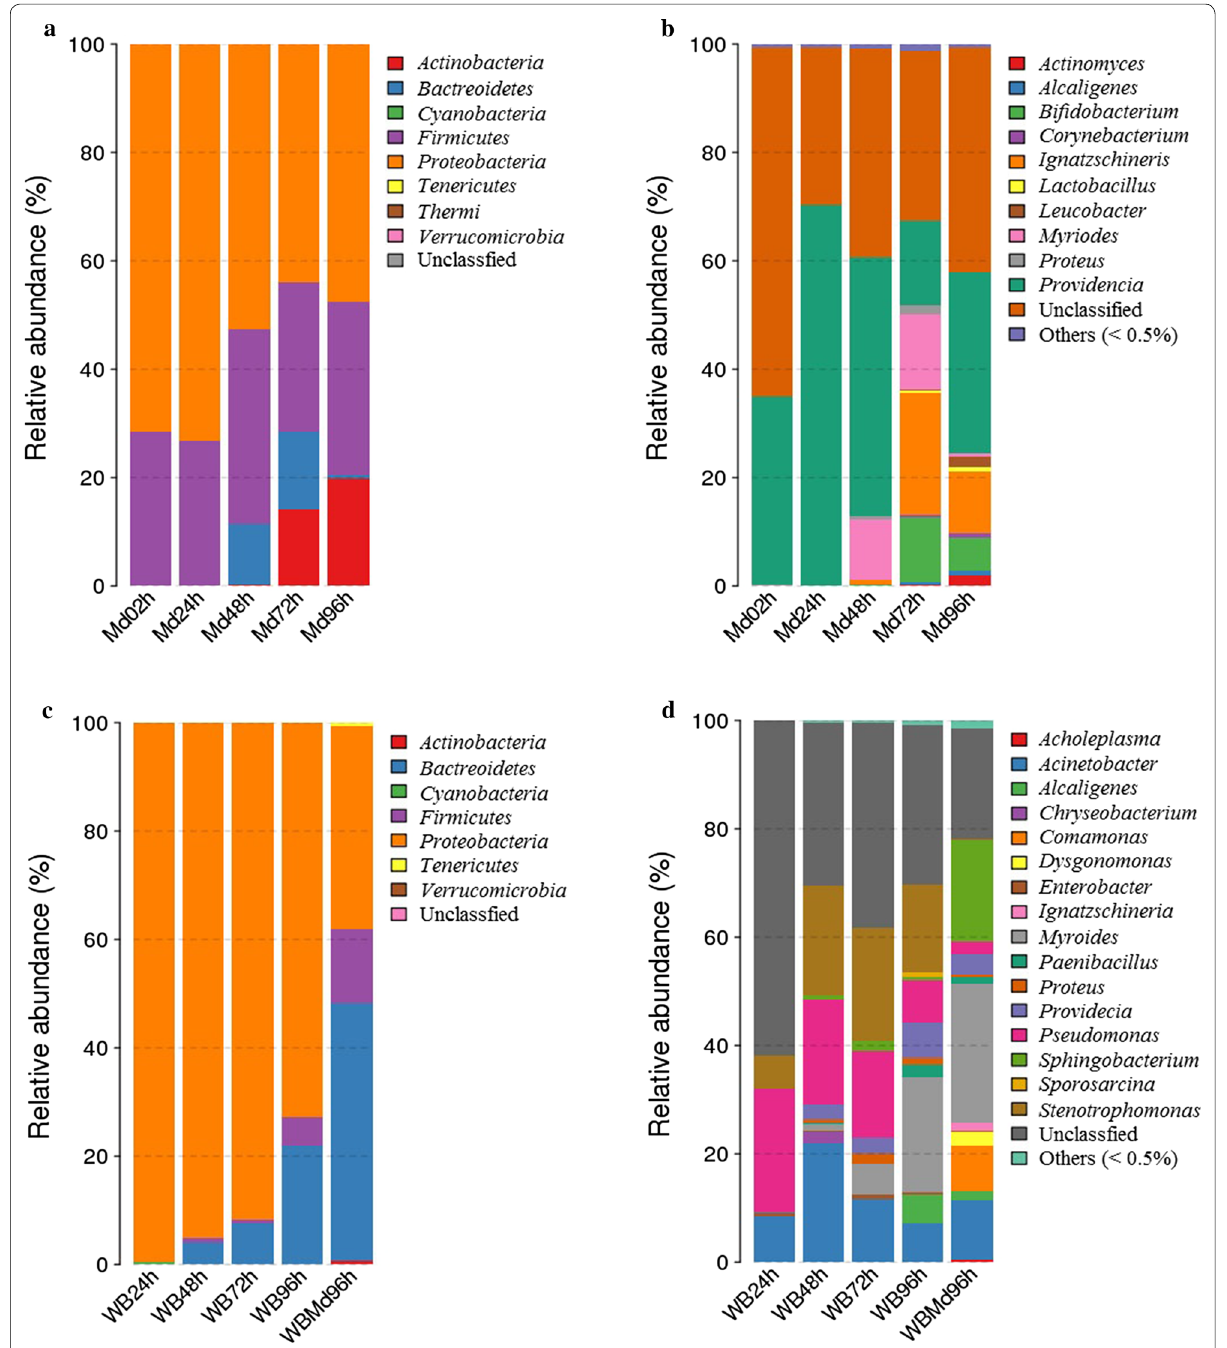
Fig. 1 Relative abundances of bacteria at the phylum and genus levels in samples of Musca domestica larvae and wheat bran. a Relative abun- dances of bacteria at the phylum level in M. domestica larvae. b Relative abundances of bacteria at the genus level in M. domestica larvae. c Relative abundances of bacteria at the phylum level in wheat bran. d Relative abundances of bacteria at the genus level in wheat bran. MD02h, MD24h, MD48h, MD72h and MD96h refer to Musca domestica larvae reared on moistened wheat bran for 2, 24, 48, 72 and 96 h. WB24h, WB48h, WB72h and WB96h refer to moistened wheat bran not treated with house fly larvae after 24, 48, 72 and 96 h. WBMd96h refers to moistened wheat bran treated with house fly larvae for 96 h. Each treatment included three biological